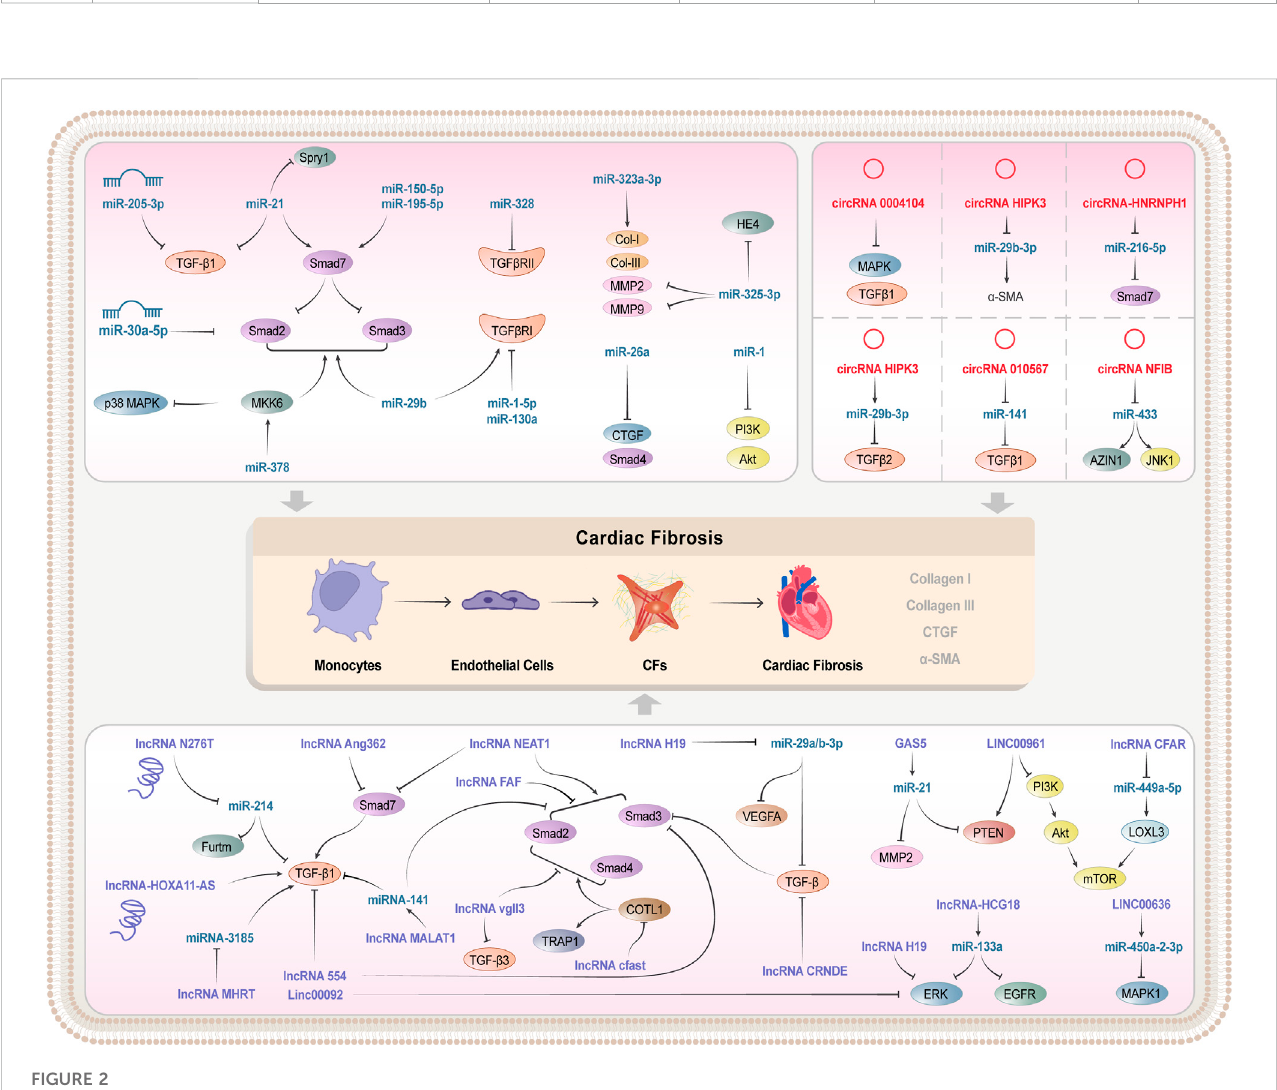
FIGURE 2 Mechanism of non-coding RNA regulating TGF- β /Smad signaling